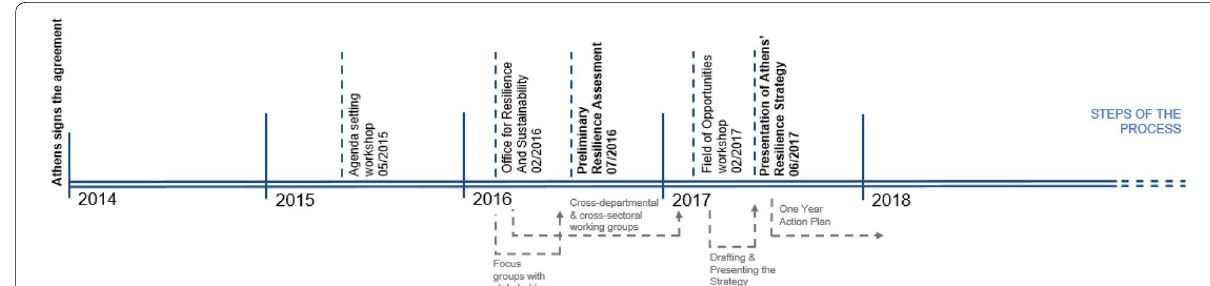
Fig. 4 Main steps of the Resilience Strategy building process in Athens. Source: Based on Resilient Athens